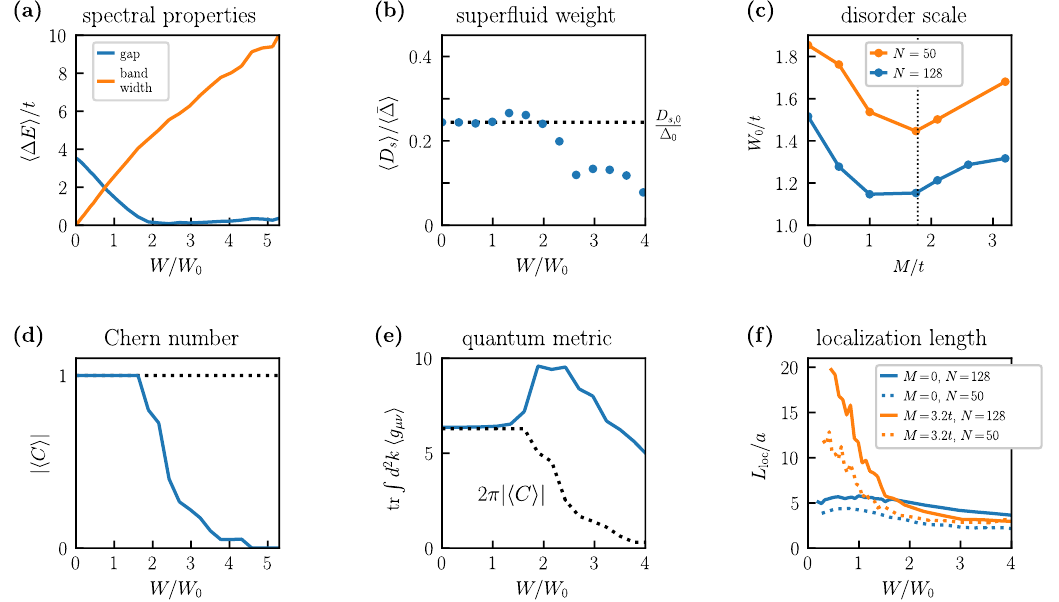
Figure 5: Disordered Kane-Mele model with optimized flatness: (a) Evolution of the band gap and the bandwidth of the lower band as a function of disorder W . (b) Relation between full superfluid weight D and sample-averaged superconducting s order parameter ¯ ∆ . (c) Disorder scale W as a function of the staggered on-site 0 potential M for two different system sizes N . The dotted black line indicates the topological transition in the clean system. (d) Evolution of the Chern number of the lower spin-up band. (e) Evolution of the trace of the quantum metric of the lower spin-up band integrated over the Brillouin zone. The dotted black line indicates the evolution of the lower bound on this integral given by the Chern number C . (f) Localization length as a function of the disorder parameter W for the flat ( M = 0) and for a trivial ( M = 3.2 t ) Kane-Mele model for two different system sizes N . The localization length is given in units of the sublattice separation a of the honeycomb